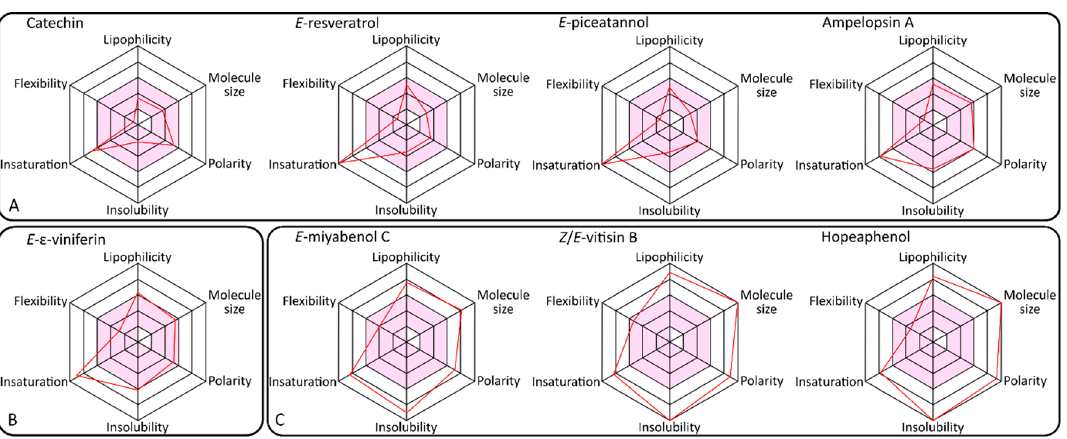
Figure 6. Availability of major GCE constituents to penetrate stratum corneum. ( A ) most potent B ) medium permeability, ( C ) less potent permeability, ( B ) medium permeability, ( C ) less potent permeability. permeability, (